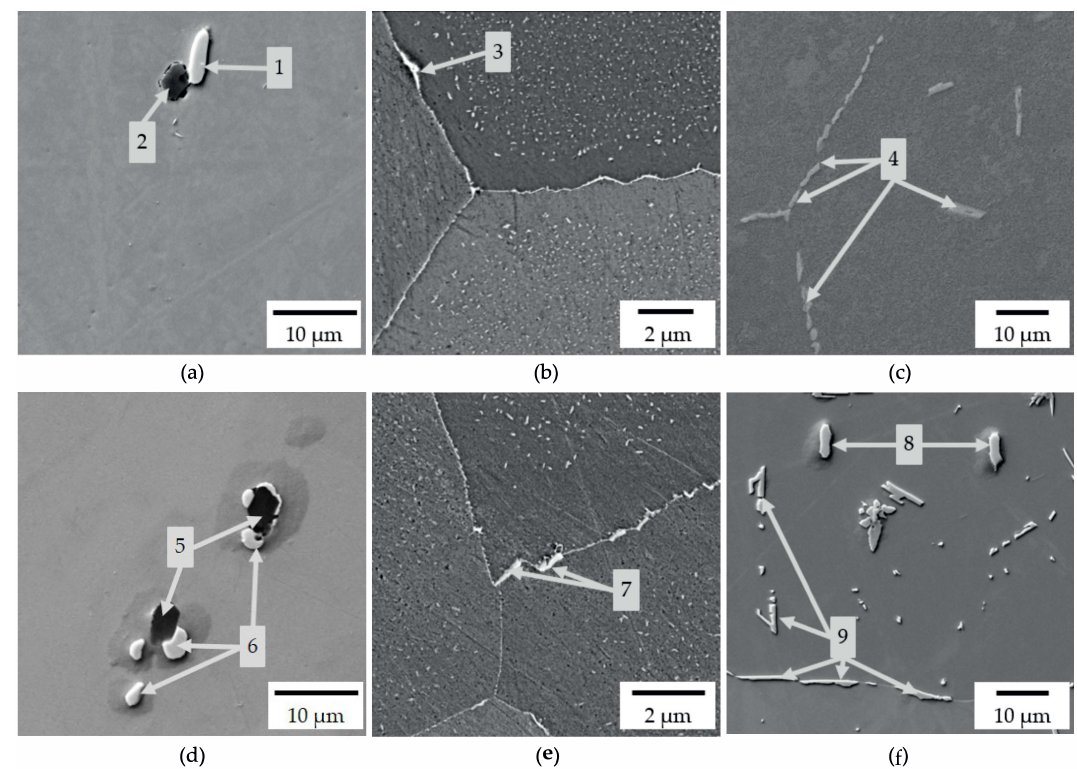
Figure 3. SEM images of the solution annealed state of the W-( a ) and Mo-concept ( d ), as well as the 650°C 8h aged samples of W-( b ) and Mo-concept ( e ) and 750°C 8h aged samples of W-( c ) and Mo-concept ( f ). Table 2. Chemical composition (wt.%) of precipitates displayed in Figure 3 measured by EDS.